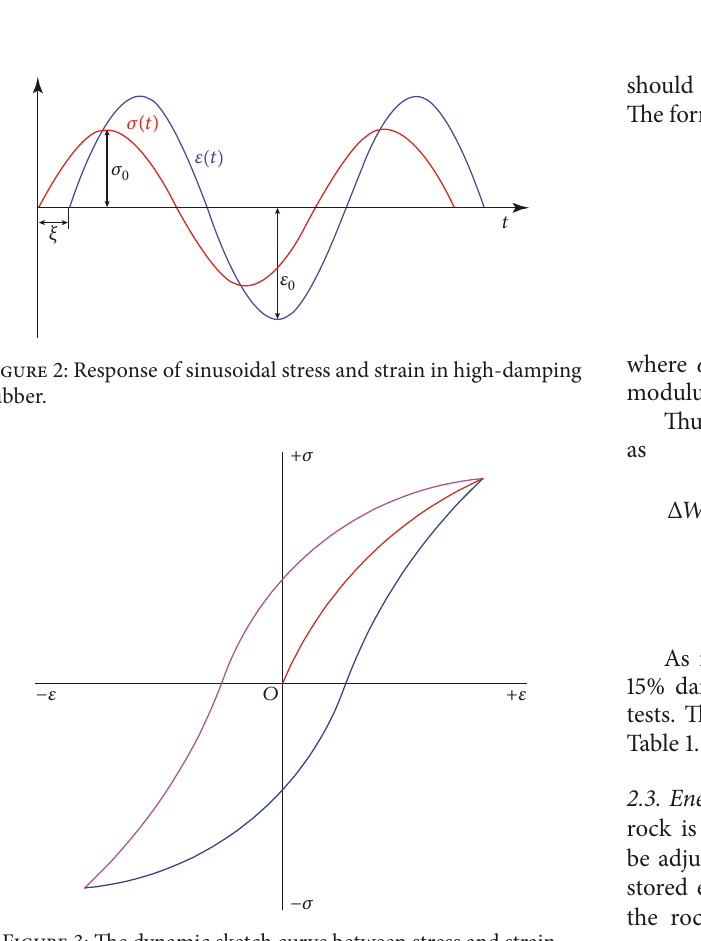
Figure 3: The dynamic sketch curve between stress and